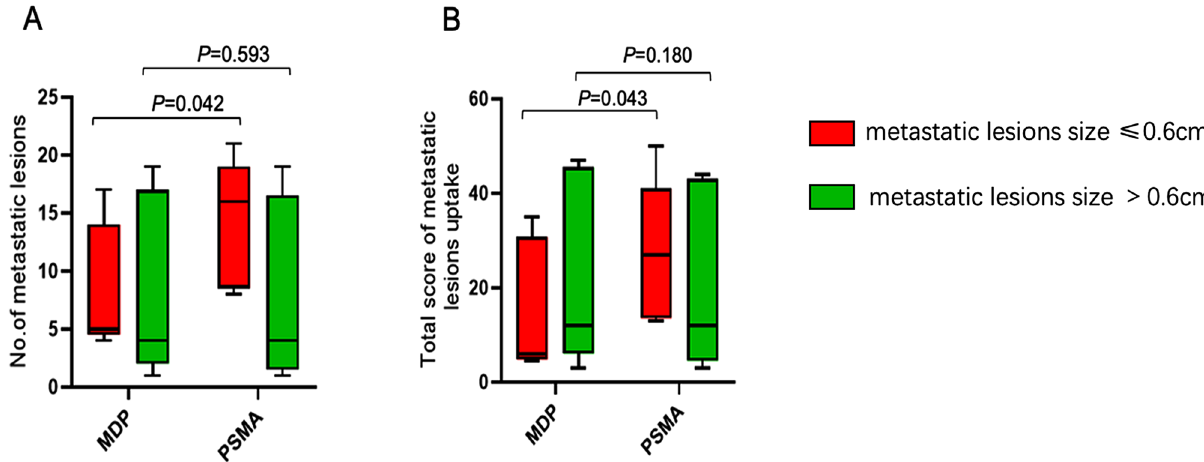
Figure 4. Comparison of metastatic lesions between the two agents. ( A ): Number of metastatic lesions detected by 99m Tc-PSMA and 99m Tc-MDP. ( B ): Degree of uptake on 99m Tc-PSMA and 99m Tc-MDP imaging.